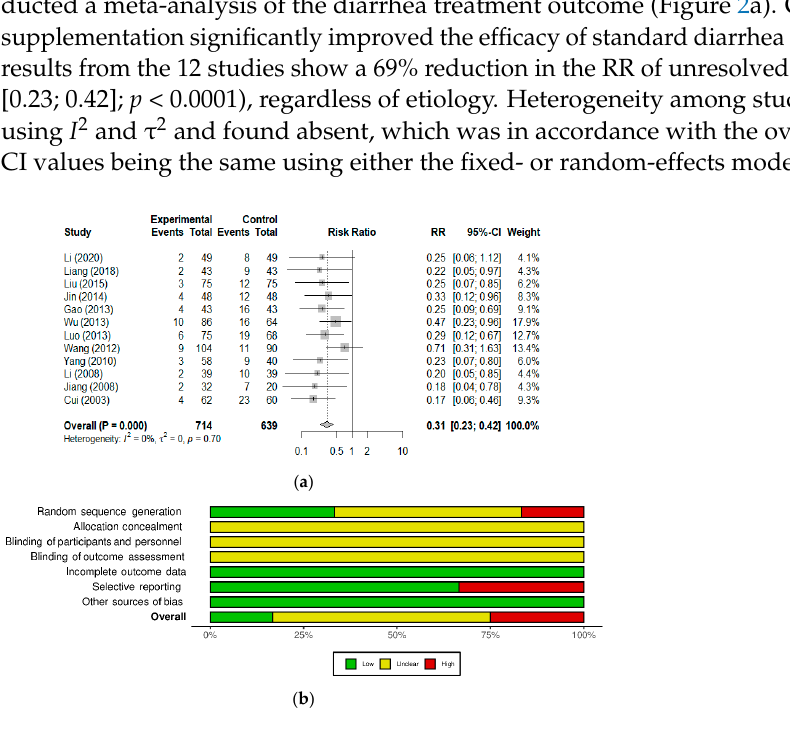
Figure 2. The probiotic formulation used as adjuvant reduced the relative risk of unresolved diarrhea. ( a ) Forest plot of studies with an efficacy outcome (effective rate) for diarrhea of various etiol- ogies. Events refers to the number of cases categorized as inefficient (unresolved diarrhea); Total refers to the number of participants in the Experimental (Probiotic) and Control groups. The 12 studies included in the meta-analysis are detailed in Table 2. (References: Cui, 2003 [22], Li, 2008 [24], Jiang, 2008 [26], Yang, 2010 [25], Wang, 2012 [20], Luo, 2013 [19], Gao, 2013 [15], Wu, 2013 [21], Jin, 2014 [23], Liu, 2015 [18], Liang, 2018 [17], Li, 2020 [16]). ( b ) Mosaic plot showing the risk of bias summary of the studies included in the meta-analysis. For the risk of bias analysis (Figure 2b), most studies included in the meta-analysis were categorized as low or unclear risk [15–18,20,22–24,26], with three studies classified as high risk of bias due to potential randomization or selective reporting issues [19,21,25]. All studies were classified as unclear risk for the allocation concealment and blinding- related domains; a similar trend was observed in a previous systematic review, which could reflect regional publication practices [41]. Publication bias was assessed using the funnel plot method (Figure 3) and asymmetry was found significant (Egger’s regression test; t = − 2.84, df = 10, p = 0.0176), suggesting the potential occurrence of publication bias. The number of missing studies to correct the asymmetry was estimated to five using the Trim and Fill method by Duval and Tweedie [11,12]. Upon inclusion of 5 negative studies in the meta-analysis (empty circles; total studies = 17), the result remained significant with the reduction in the risk of unresolved diarrhea changing from 69% to 62.5% (RR 0.3753 [0.2867; 0.4913]; p < 0.0001).